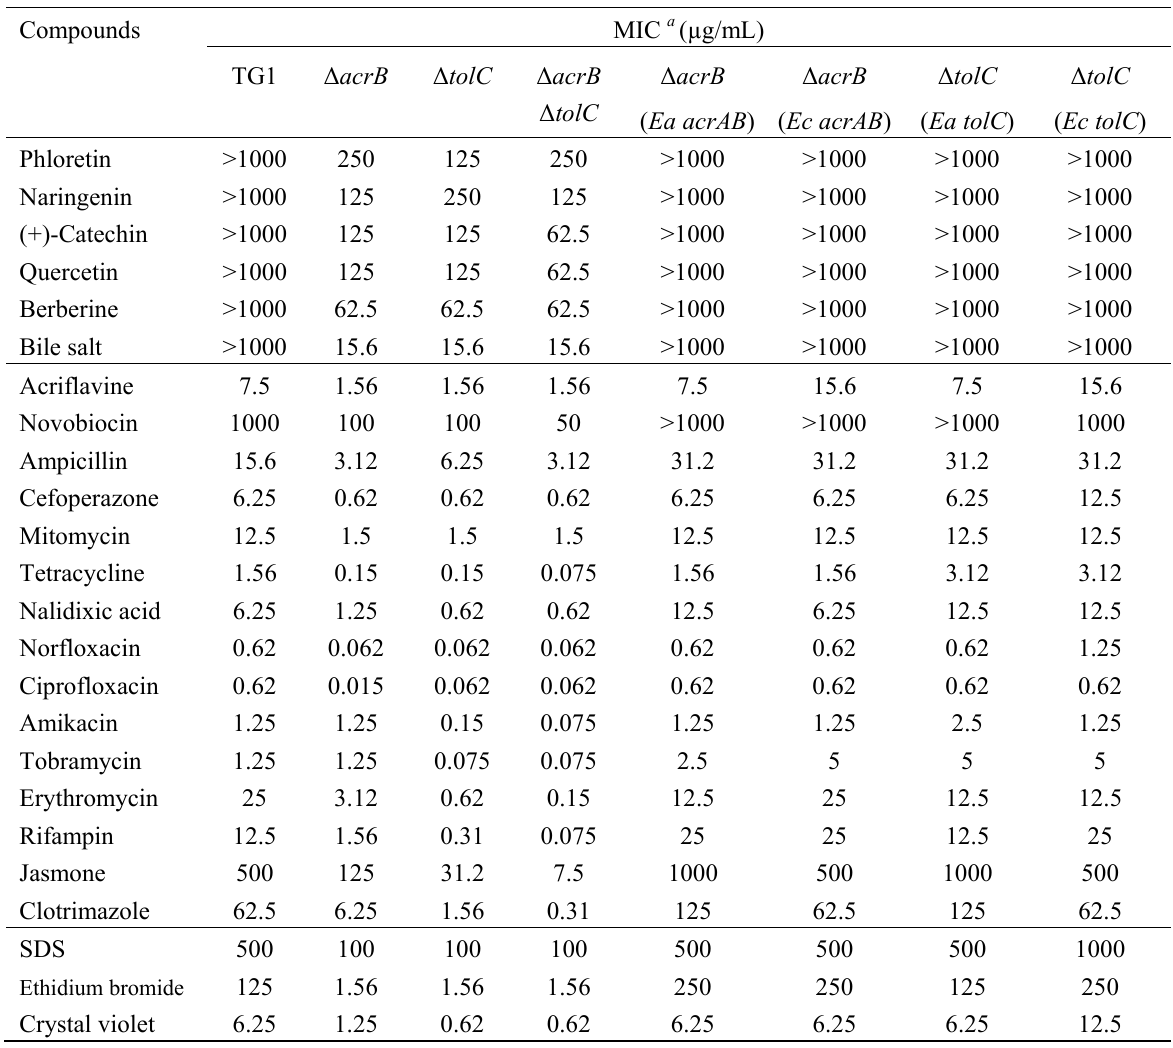
Table 3. Susceptibility of Escherichia coli strains to different compounds in minimal medium